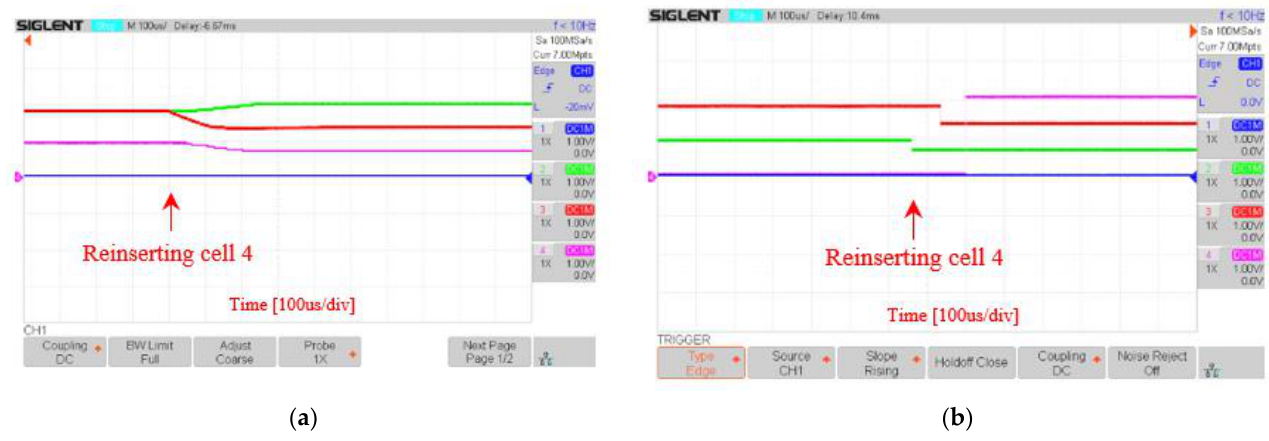
Figure 48. Reconfiguration system response when reinserting cell 4, ( a ) conventional method; ( b ) proposed DSA-PSC method.